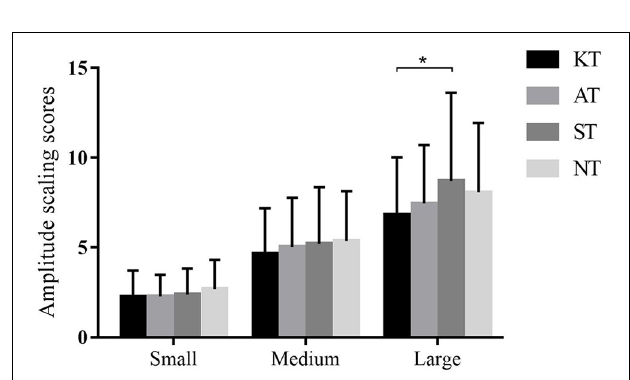
FIGURE 4 | Sway energy of four different taping treatments in ADT. * p < 0.05.